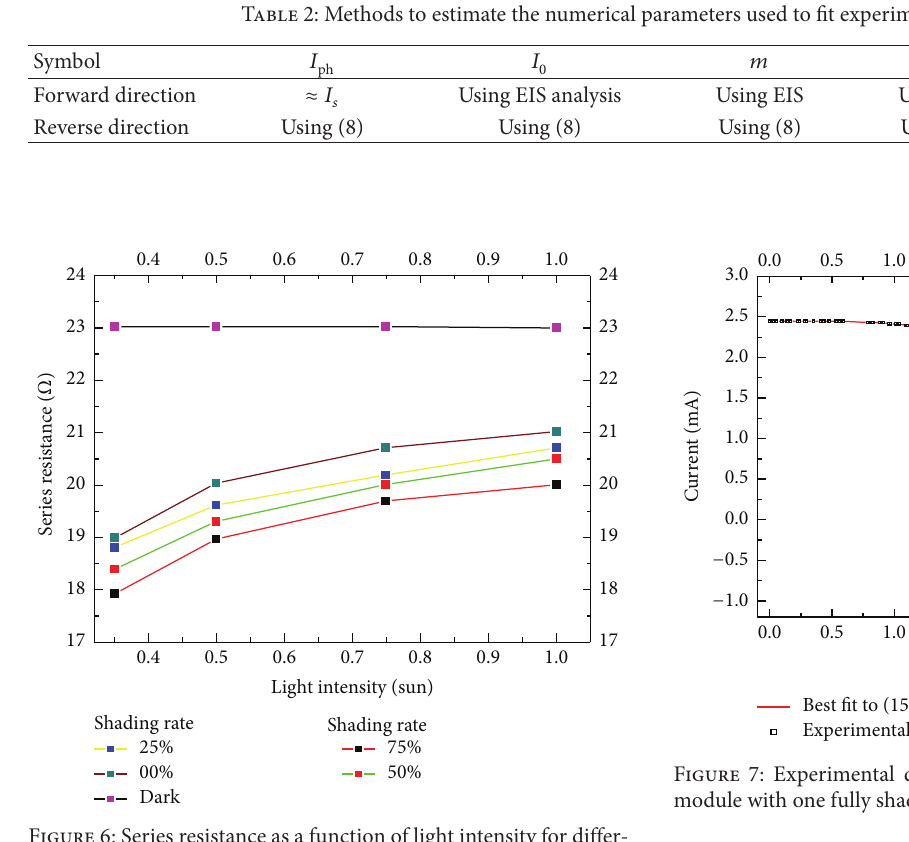
Figure 6: Series resistance as a function of light intensity for differ- ent shading rates.